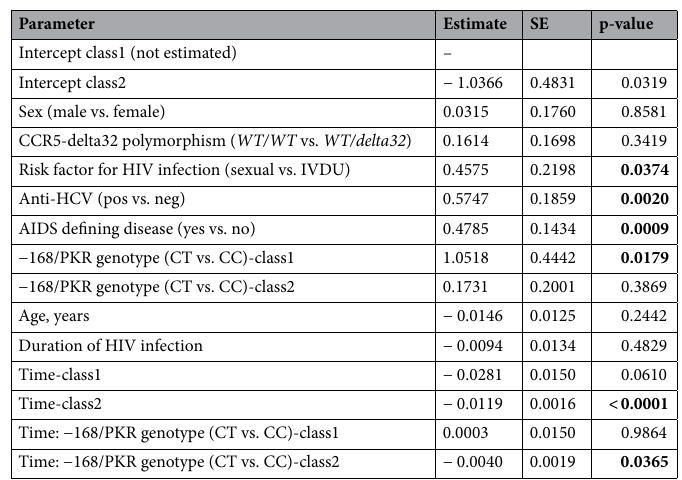
Table 4. Estimated latent class mixed model for HIV load (Log10 transformed) with two latent classes. The term “time: −168/PKR genotype” indicates the parameter for the interaction term, i.e., it describes the progression of HIV load separately for each allelic variant and for each latent class (class1 or class2). WT/WT wild type, anti-HCV hepatitis C virus antibodies, AIDS acquired immune deficiency syndrome, PKR protein kinase R. Significant coefficients are in